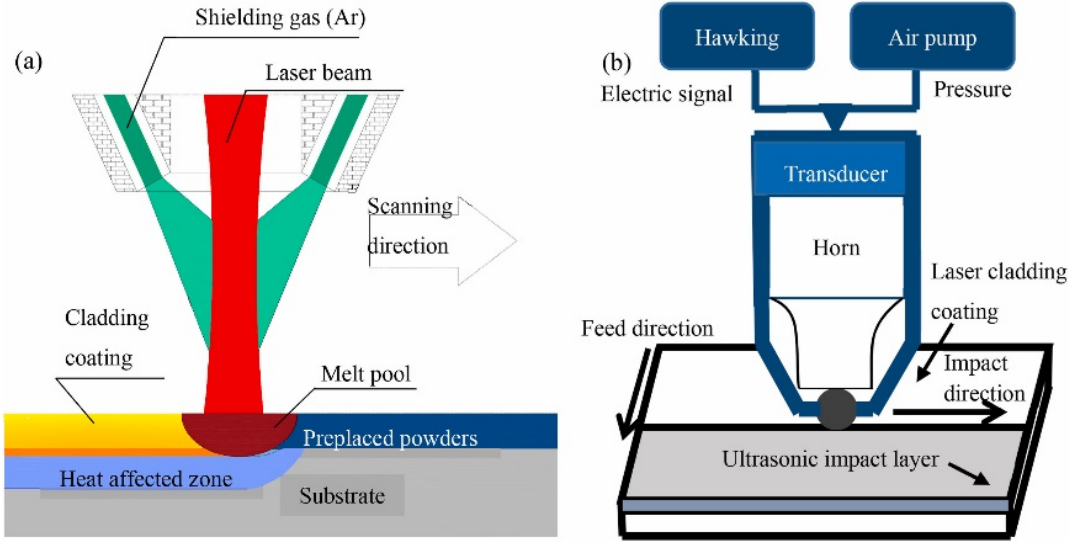
Figure 6. ( a ) Schematic diagram of laser cladding process; ( b ) schematic diagram of ultrasonic impact treatment on the surface of laser cladding coatings. (Reprinted with permission from ref. [41]. Copyright 2021 Elsevier).